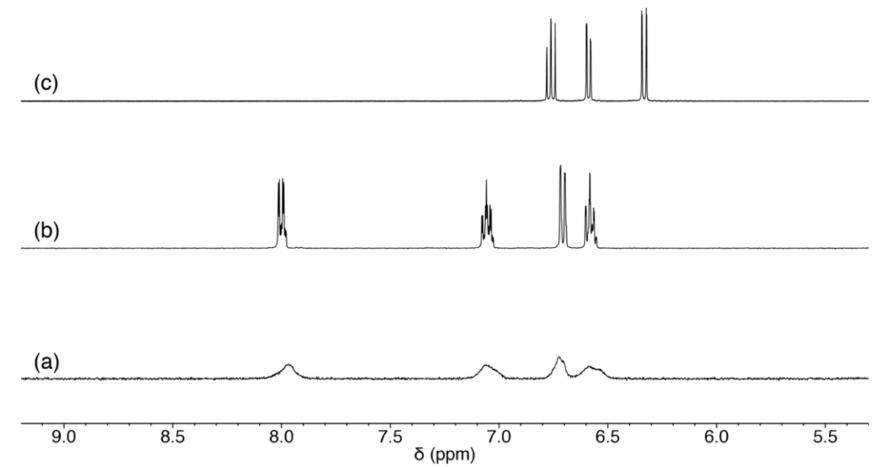
Figure 2. 1 H NMR spectra of ( a ) 1 , ( b ) 1 (cid:48) in CD 3 OD, and ( c ) 2 in CD 3